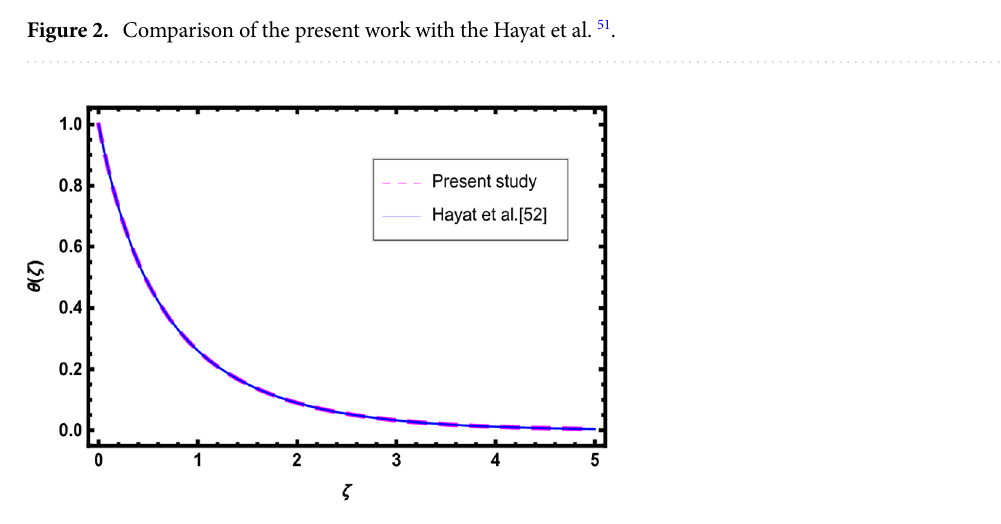
Figure 3. Comparison of the present work with the Hayat et al. 51 .